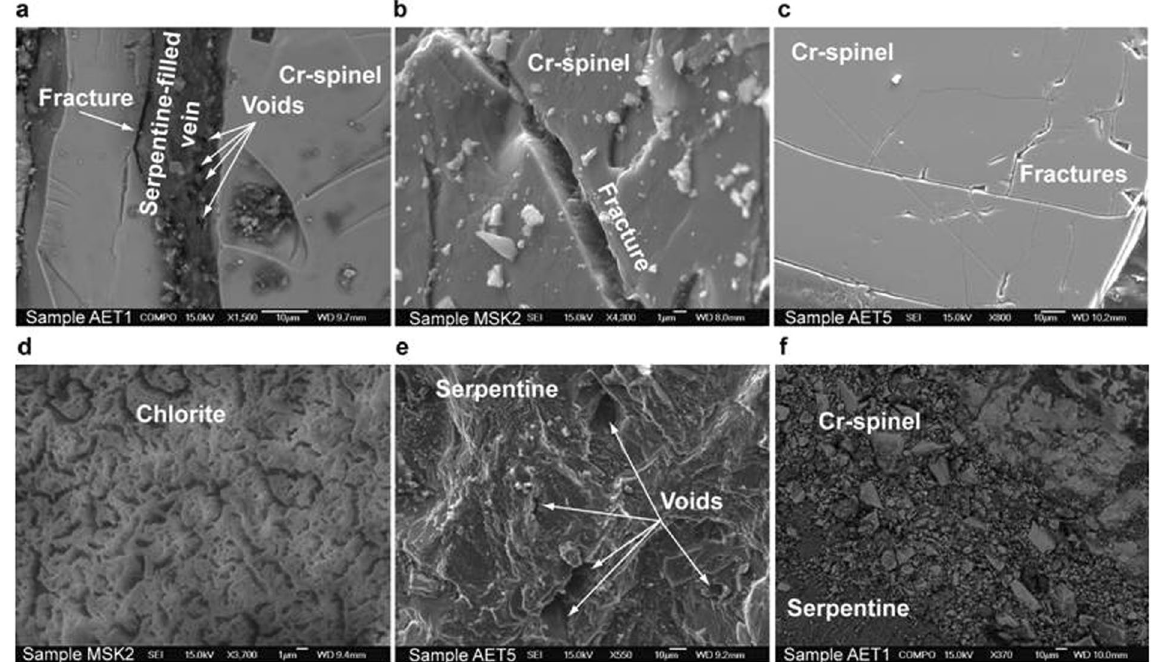
Figure 4. Fractures, veins and voids in chromitites. Examples of microstructures observed in secondary electron images in the CH 4 -rich samples AET1, AET5 and MSK. ( a ) Serpentine filled vein with pores and fracture at the boundary between serpentine and Cr-spinel. ( b ) Detail of a crack in a Cr-spinel crystal. ( c ) Fractures in Cr-spinel. ( d ) Pores in chlorite. ( e ) Detail of the voids in serpentine. ( f ) Tectonically fragmented